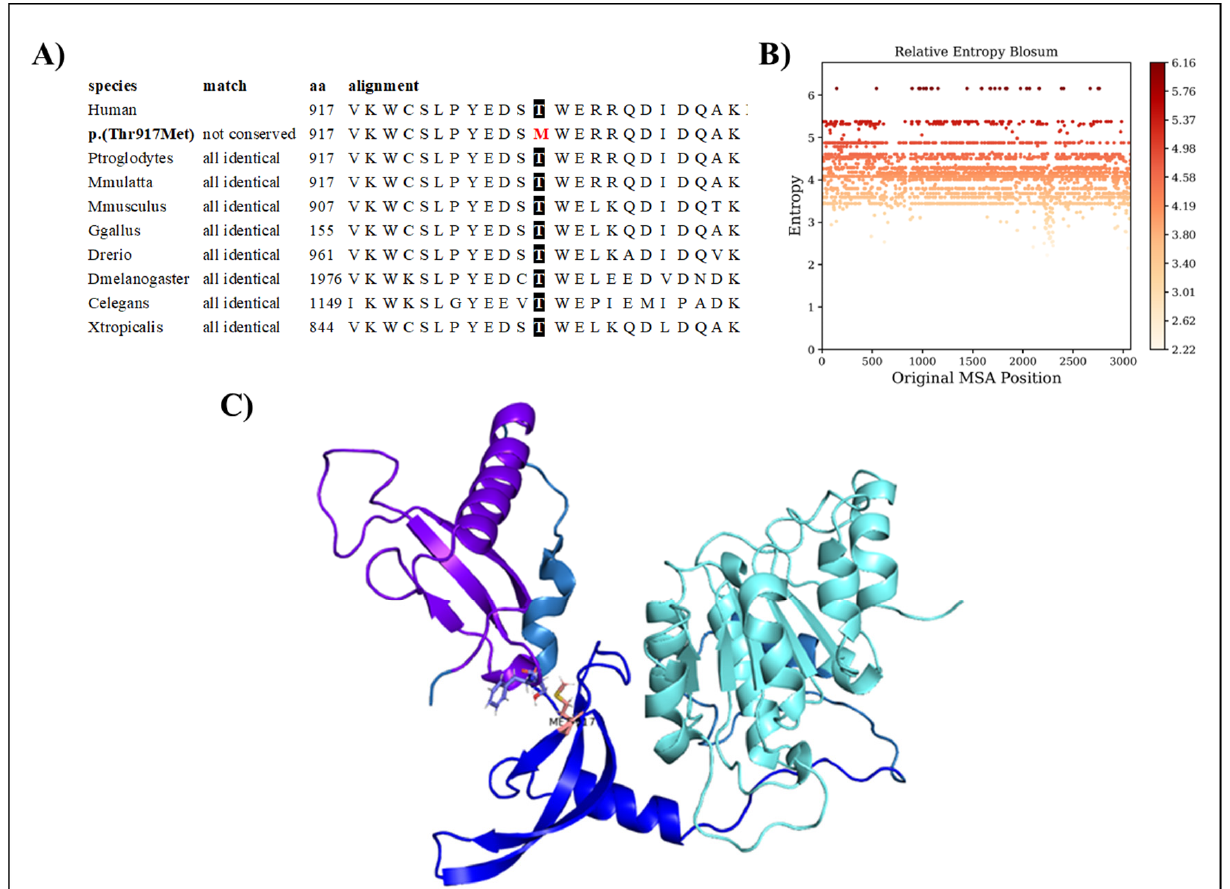
Figure 3. ( A ) Amino acid conservation across species of the CHD7 variant, showing that Thr917 is highly conserved. ( B ) Relative entropy plots. ( C ) CHD7 domains shown in different colors, with the variant shown in pink.